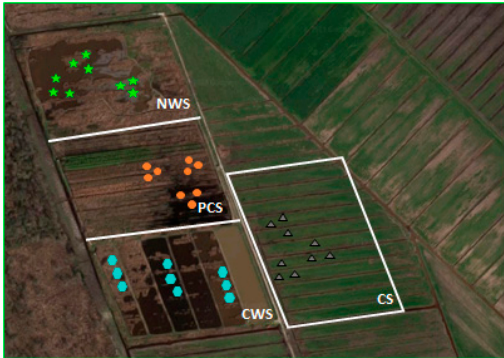
Figure 1. Overview of the experimental field (CWS: constructed wetland system, PCS: paludiculture system, NWS: natural wetland system, CS: conventional system). For each system, sampling points are represented with different shapes.